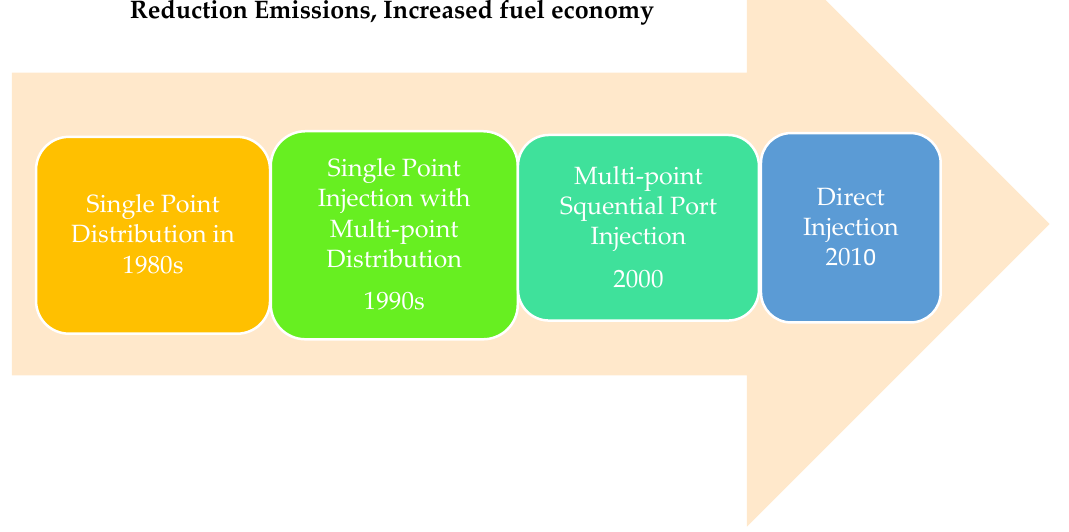
Figure 9. Technological development of fuel-injection systems [193].